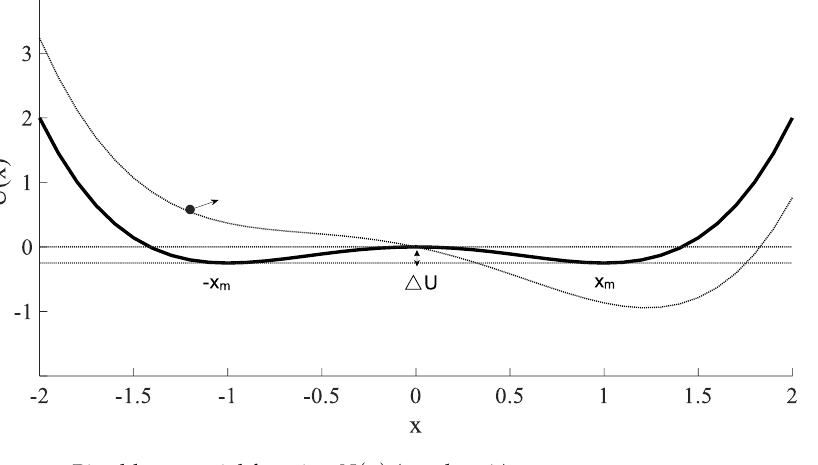
Figure 1. Bistable potential function U ( x ) ( a = b = 1